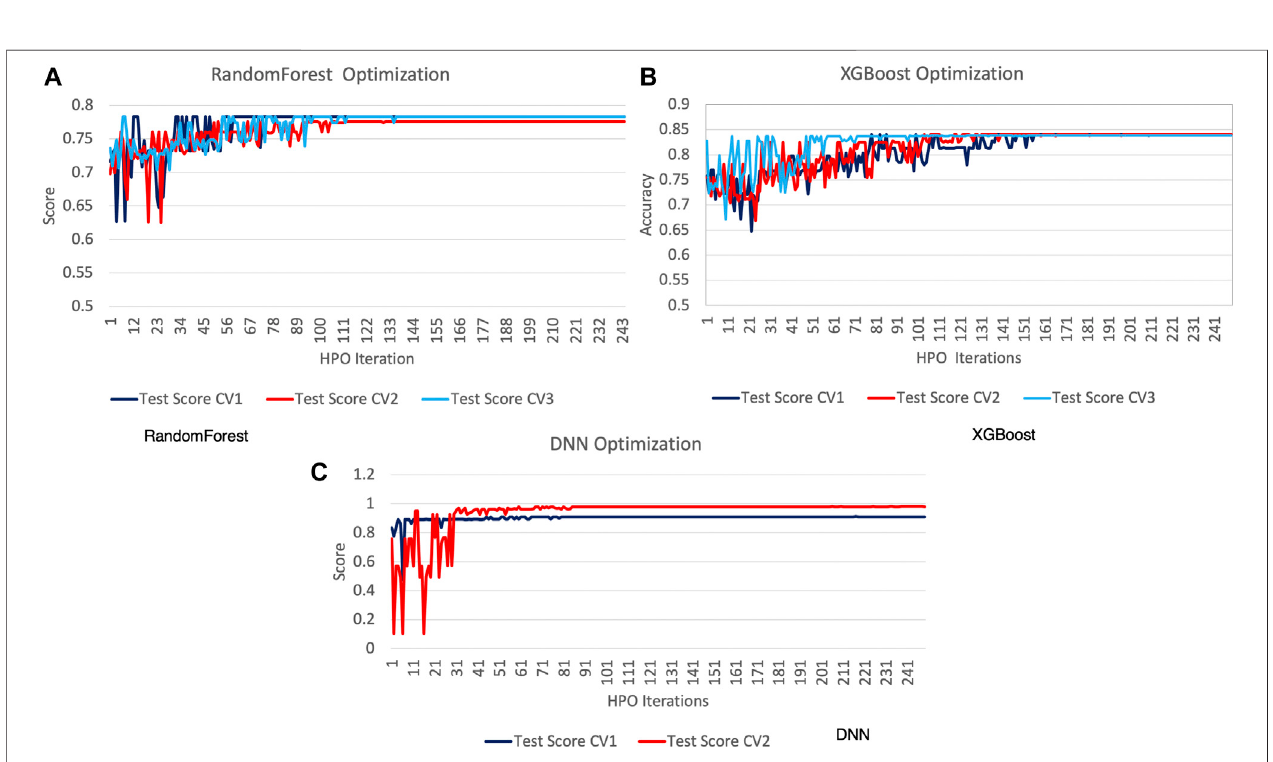
FIGURE 8 | Hyperparameter optimization experimental